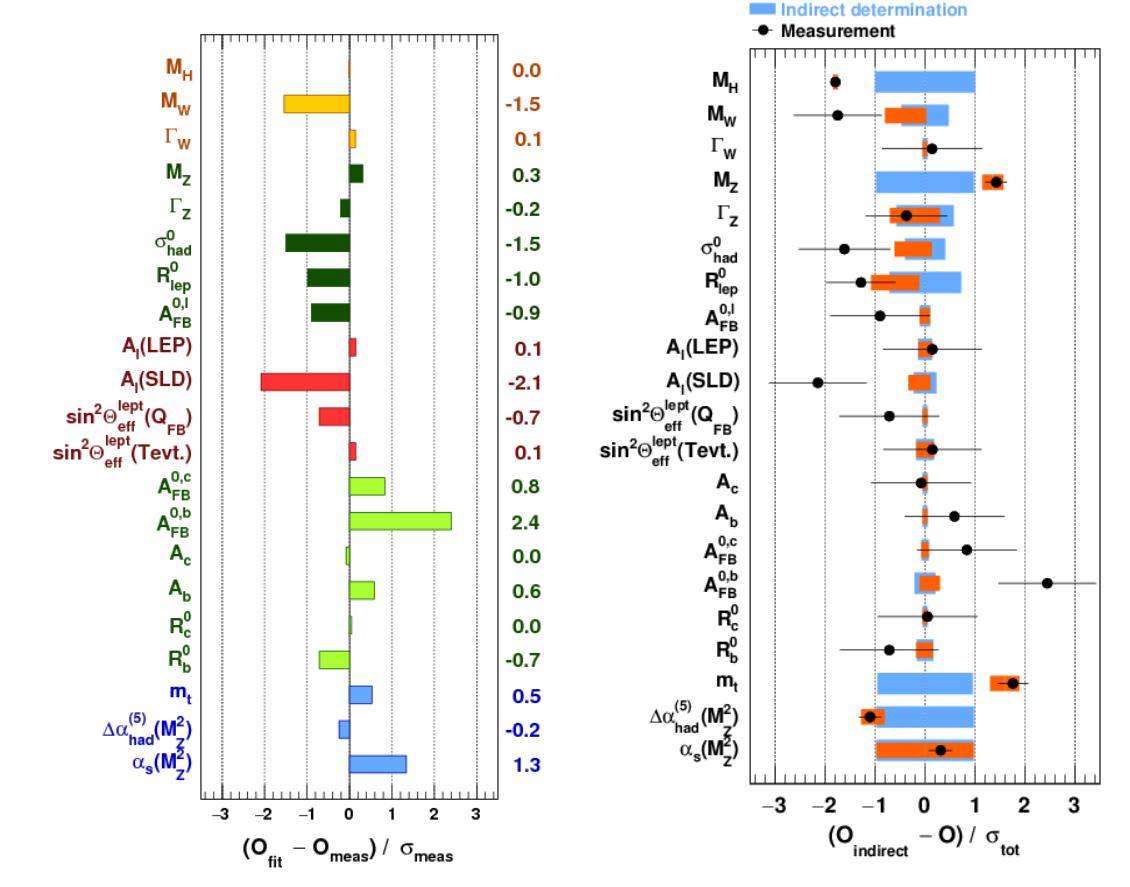
Figure 1. Recent results of testing the standard model [1]. ( Left ) Relative deviations of the measured values for selected model parameters from the fitted ones. ( Right ) Similar fitting performed with the given model parameter left floating, showing the sensitivity of the model to its parameter